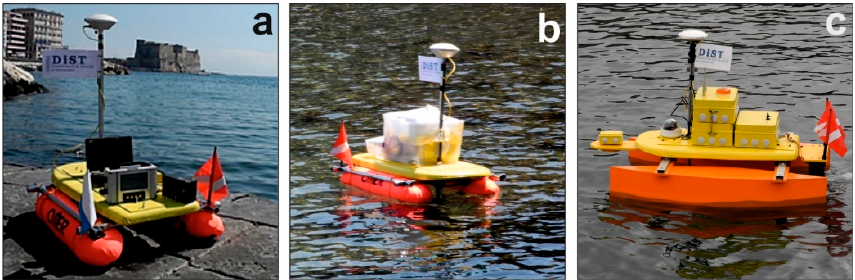
Figure 1. ( a ) Instruments on board of MicroVeGA; ( b ) Prototype #1 of MicroVeGA; ( c ) Prototype #2 of MicroVeGA.